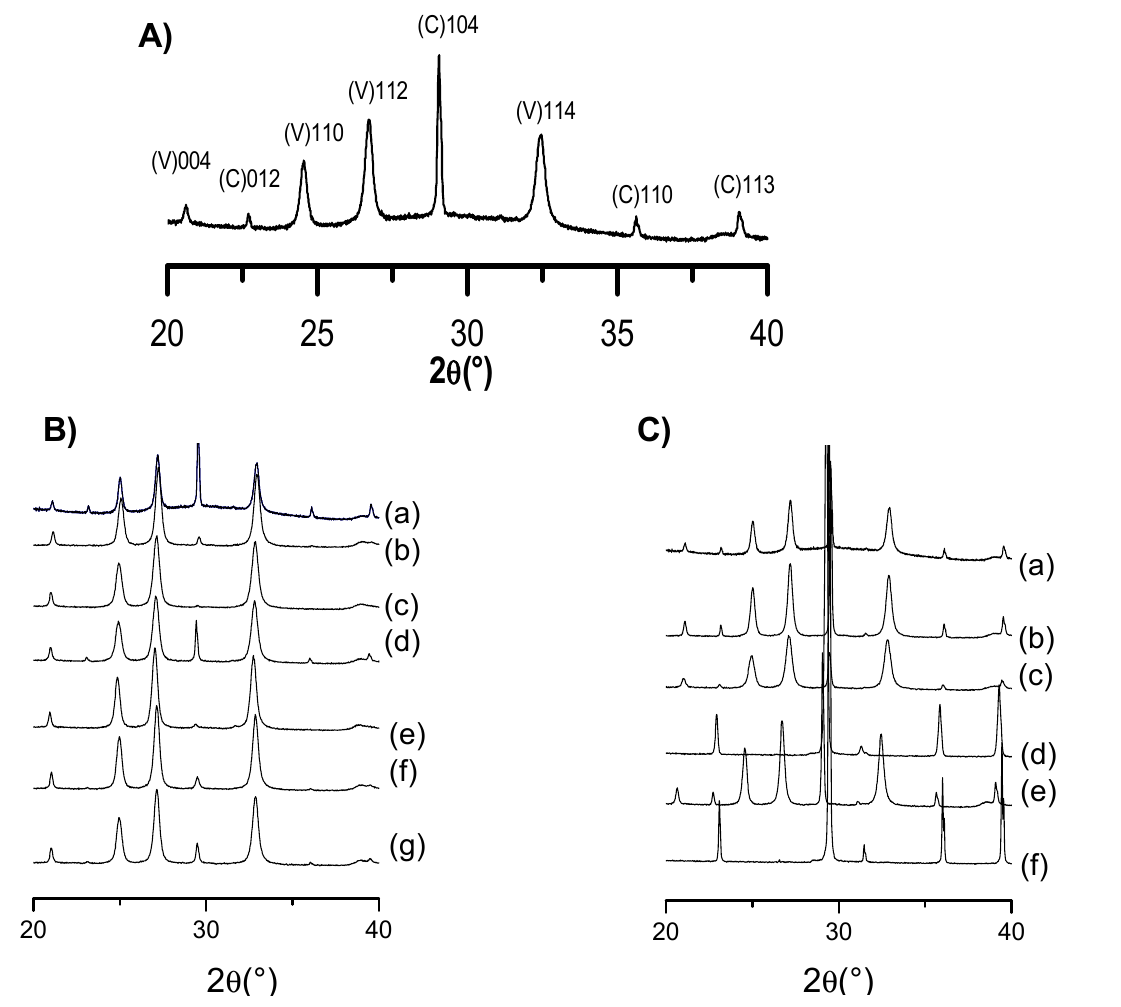
Figure 4. XRD patterns of ( A ) CD-CaCO 3 particle, ( B ) CD-CaCO 3 particle with PVSA and ( C ) CD- CaCO 3 particle with glycerol. ( B ) (a) CD-CaCO3 microparticle, (b) CD-PVSA_30